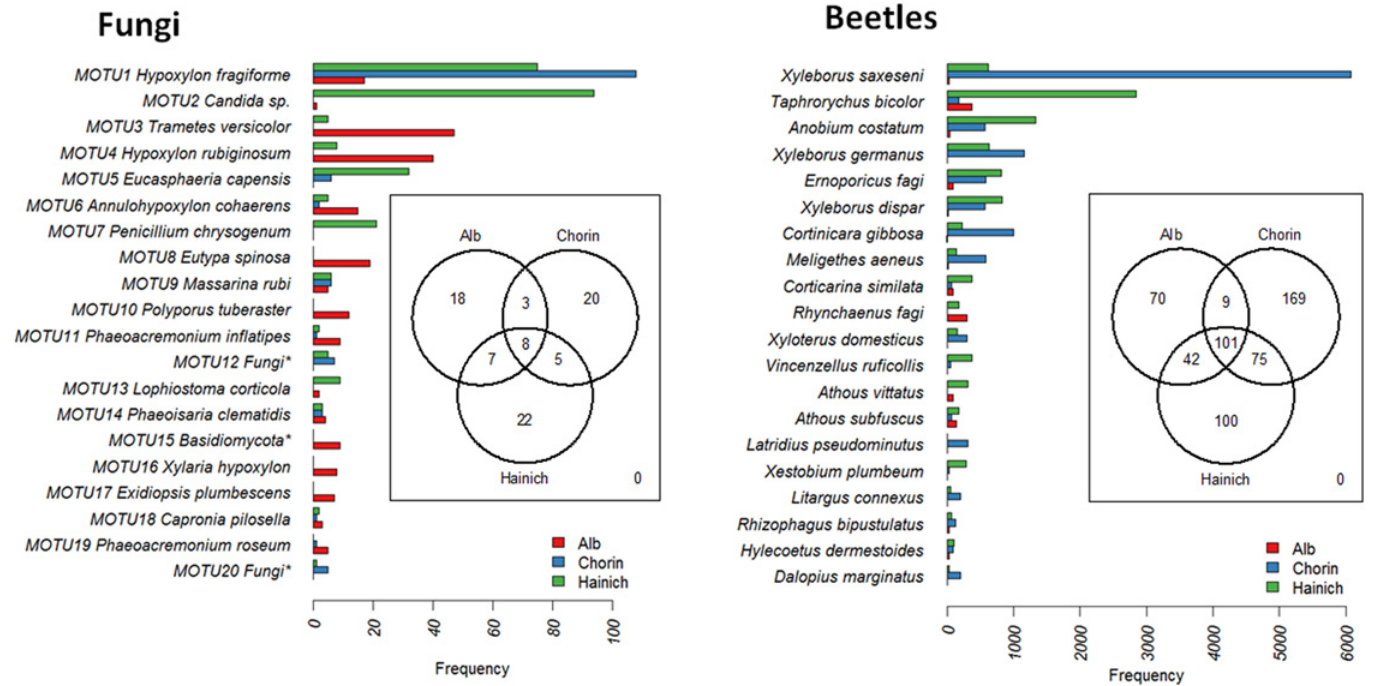
Fig 1. The 20 most abundant MOTUs (left) and species of beetles (right) respectively collected from all regions. Embedded Venn diagrams show the low proportion of taxa occurring in all regions. * = lower taxonomic rank could not be determined for the MOTUs labeled as Fungi and